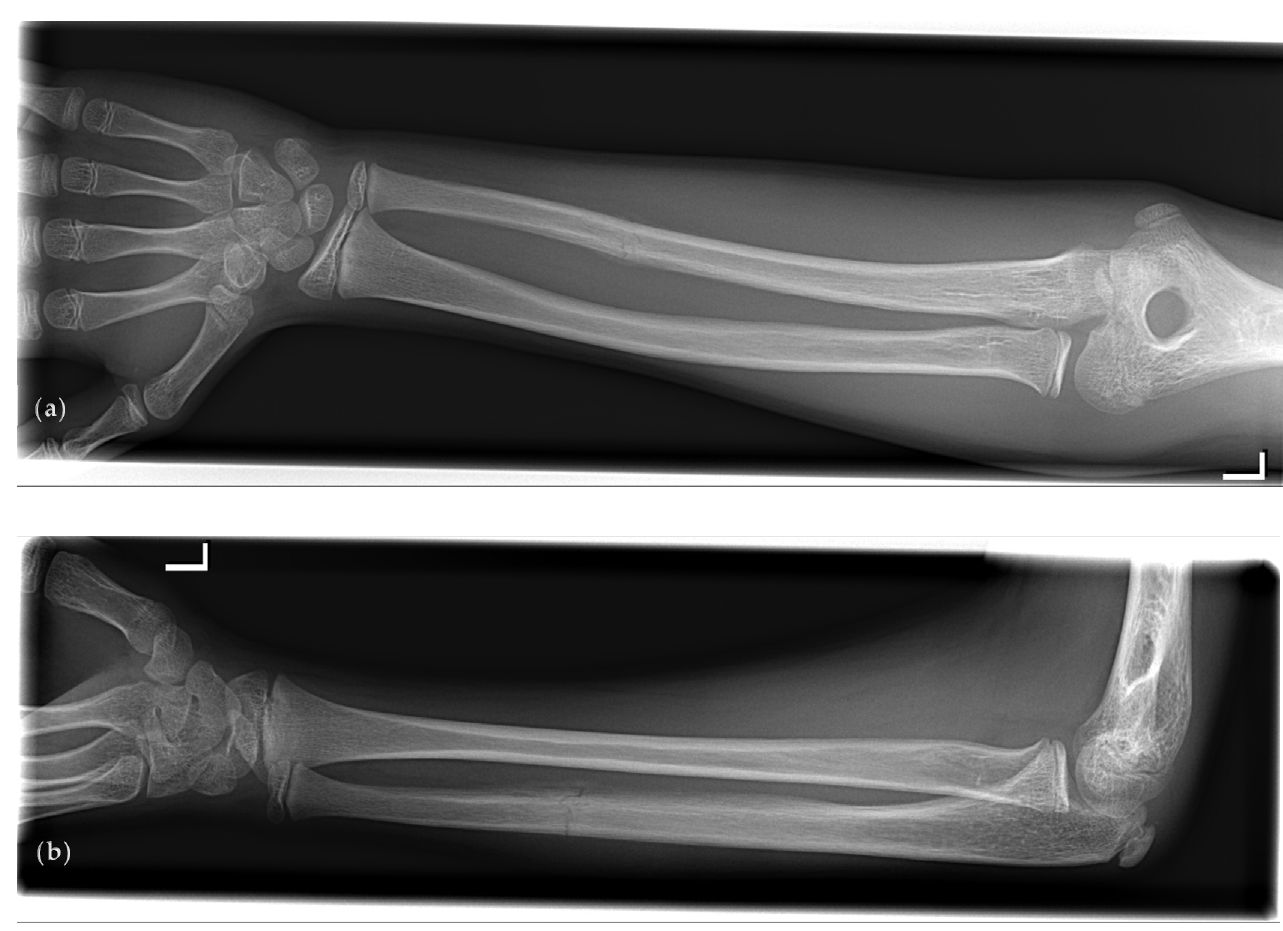
Figure 1. A typical example of an isolated fracture of the left ulna that meets all four parry fracture criteria according to Judd [1]: absence of radial involvement, transverse fracture line, distal from midshaft, and minimal displacement. Radiographs are shown in ( a ) anteroposterior projection; ( b ) lateral projection.